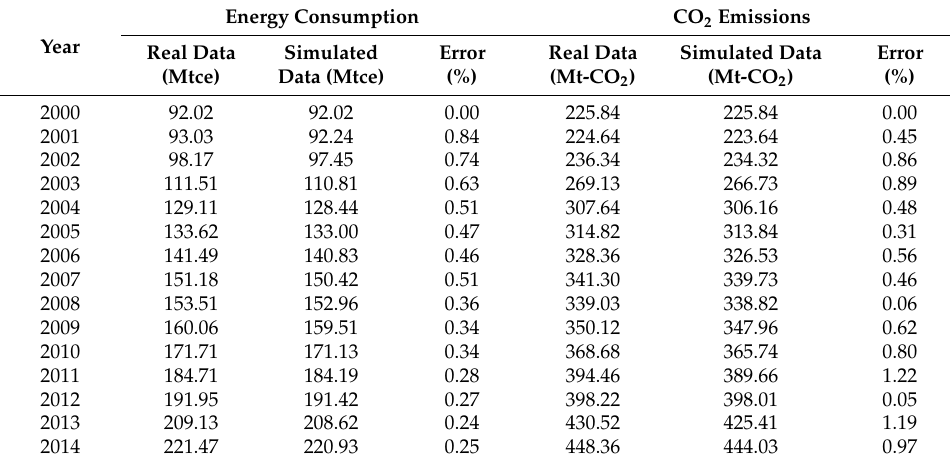
Table 4. Simulated data versus historical